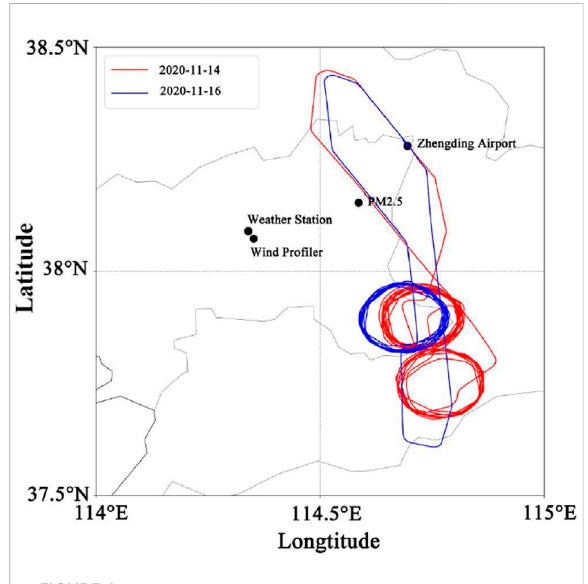
Flight trajectory on November 14th (red) and 16th (blue), 2020, and locations of observation